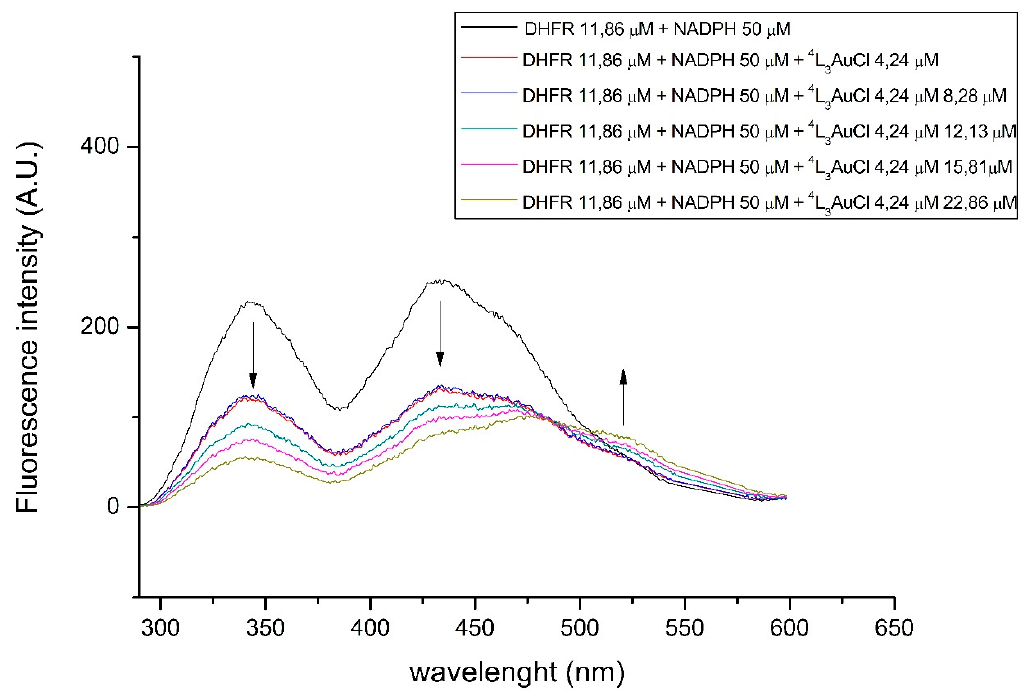
Figure 8. Emission spectra recorded upon the addition of Hepes / methanol solution of 4 L 3 AuCl into the DHFR solution saturated with NADPH ( λ exc = 280 nm). In the inset legend, the color corresponds to the curve and the respective concentration.